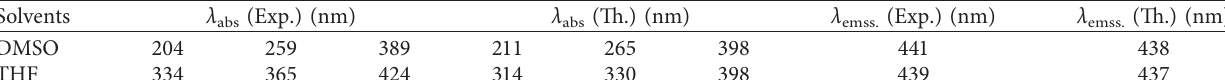
Table 4: Experimental (Exp.) and theoretical (Th.) maximum absorption ( λ within DMSO and THF solvents. CAM-B3LYP/6-311G++ (d, p) was applied.